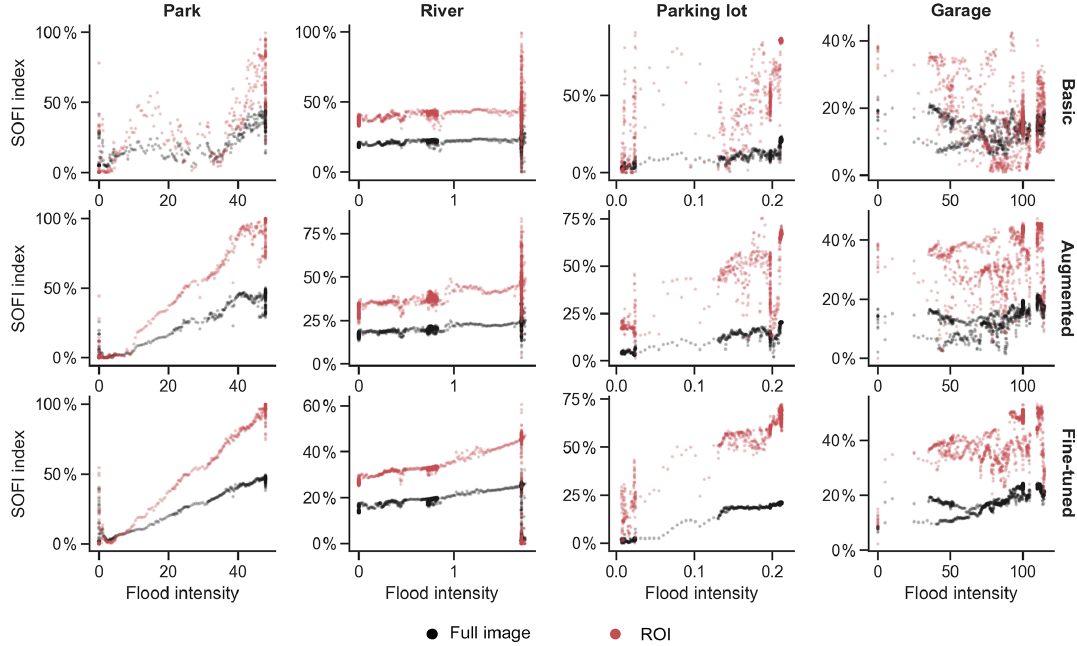
Figure 8. Videos without reference measurements: SOFI computed from full images (black) or from a ROI (red) plotted against visually estimated flood intensity, for different training strategies. There is a visible reduction of noise and increased correlation with the Augmented and Fine-tuned strategies.